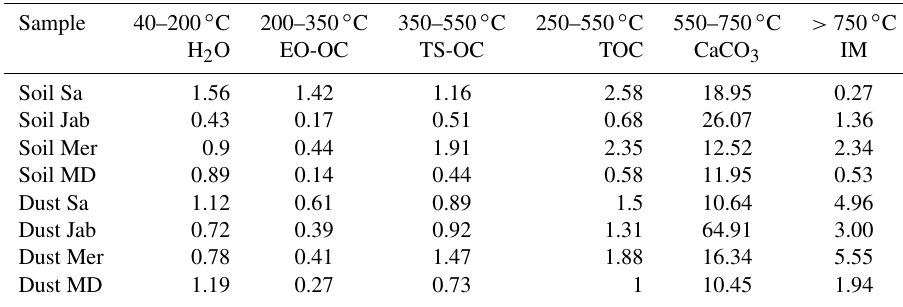
Table 5. Weight loss in percent, quantified with TGA-MS coupled with DSC thermograms in terms of different volatile and oxidizable